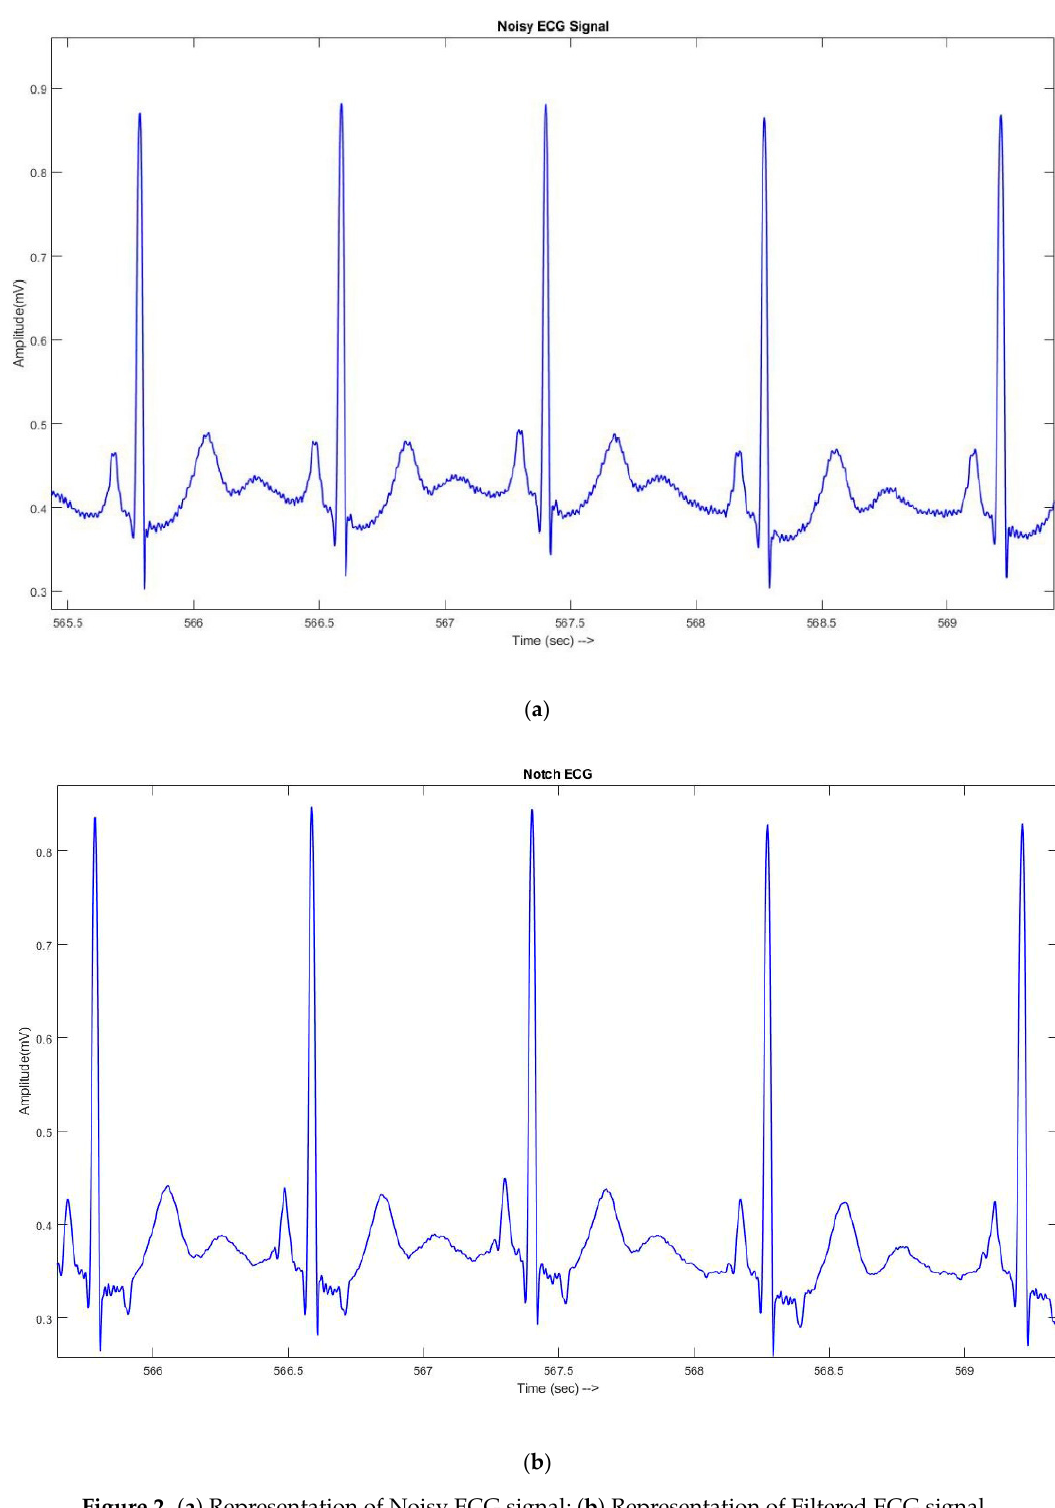
Figure 2. ( a ) Representation of Noisy ECG signal; ( b ) Representation of Filtered ECG signal.